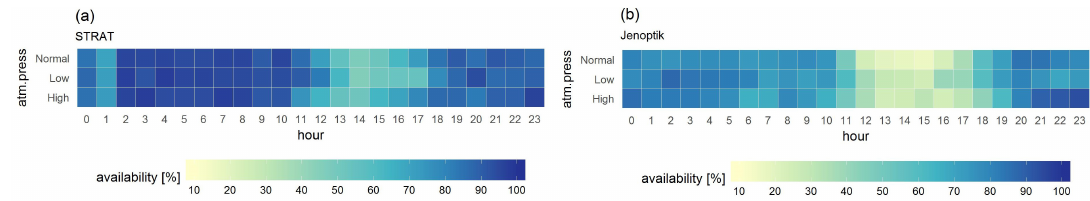
Figure 7. Diurnal evolution of the availability of MLH determined by STRAT ( a ) and Jenoptik ( b ) algorithms at “Normal”, “Low” and “High” atmospheric pressure in summer of